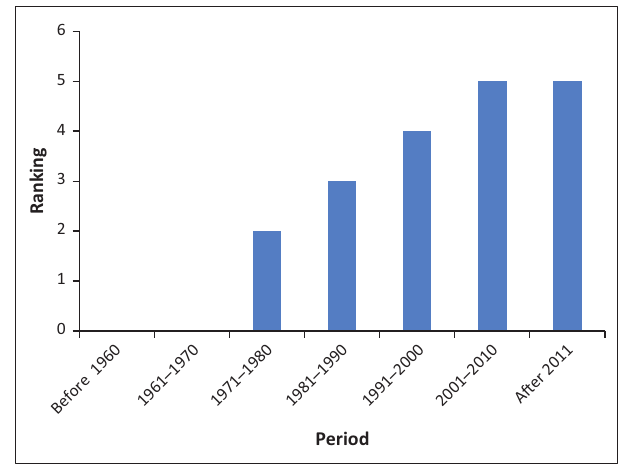
FIGURE 2: Perceived malaria trends 1960–2014: ward